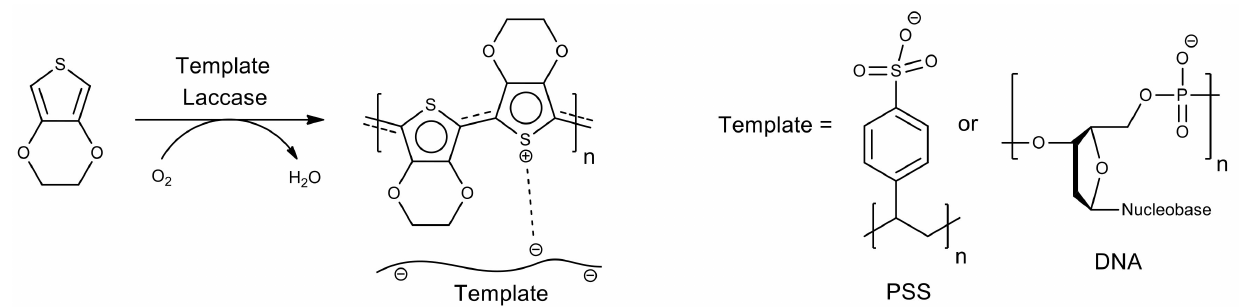
Figure 3. Schematic illustration of the laccase-catalyzed 3,4-ethylenedioxythiophene polymerization in the presence of polystyrene sulfonate (PSS) or DNA as a